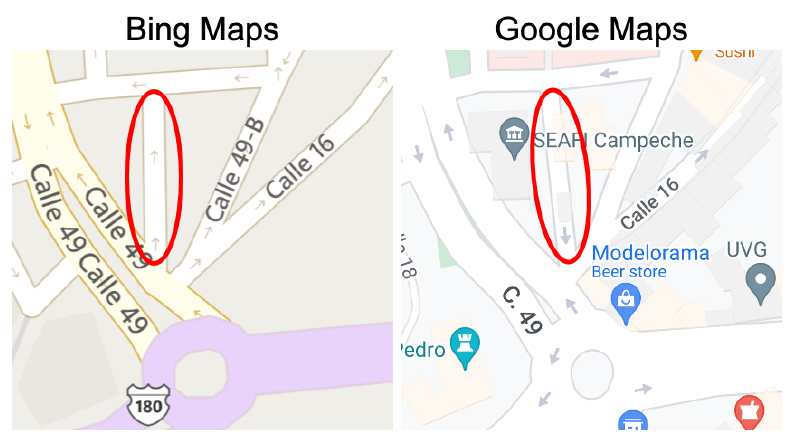
Figure 22. Type 2 (strong discrepancy) example #4-Italy.